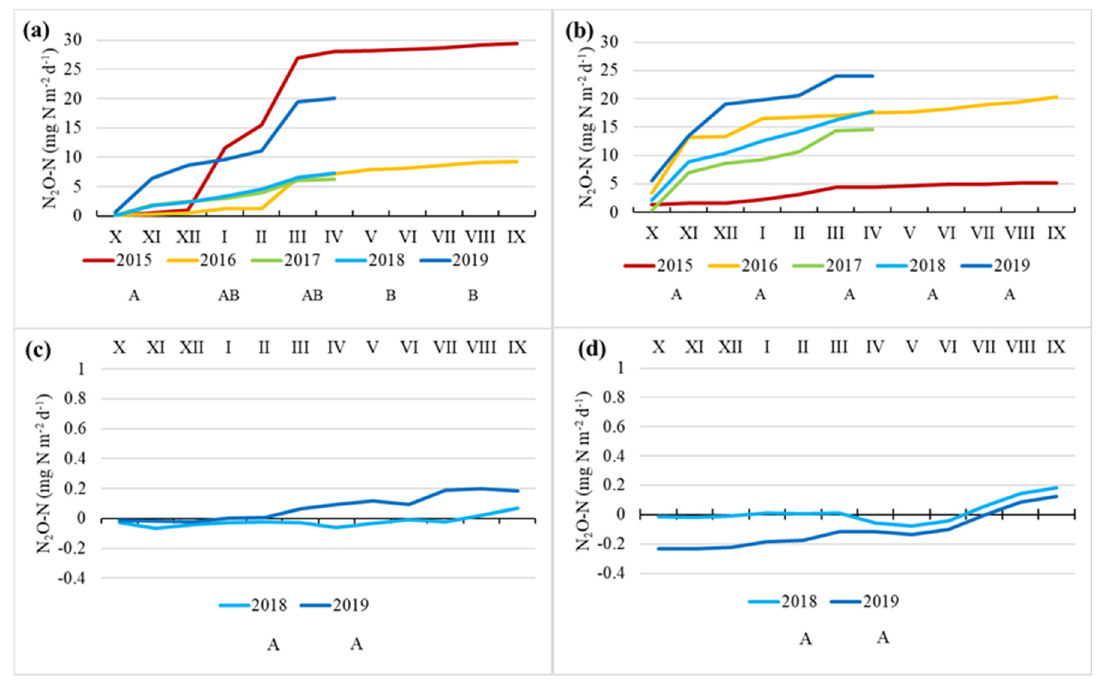
Figure 9. Cumulative annual N 2 O-N emissions at Norway spruce ( a ) and Downy Birch ( b ) drained peatland forests and Ess-soo ( c ) and Laiuse ( d ) abandoned peat extraction areas. A and B—significantly differing values (Kruskal–Wallis ANOVA test and multiple comparison of mean ranks test).